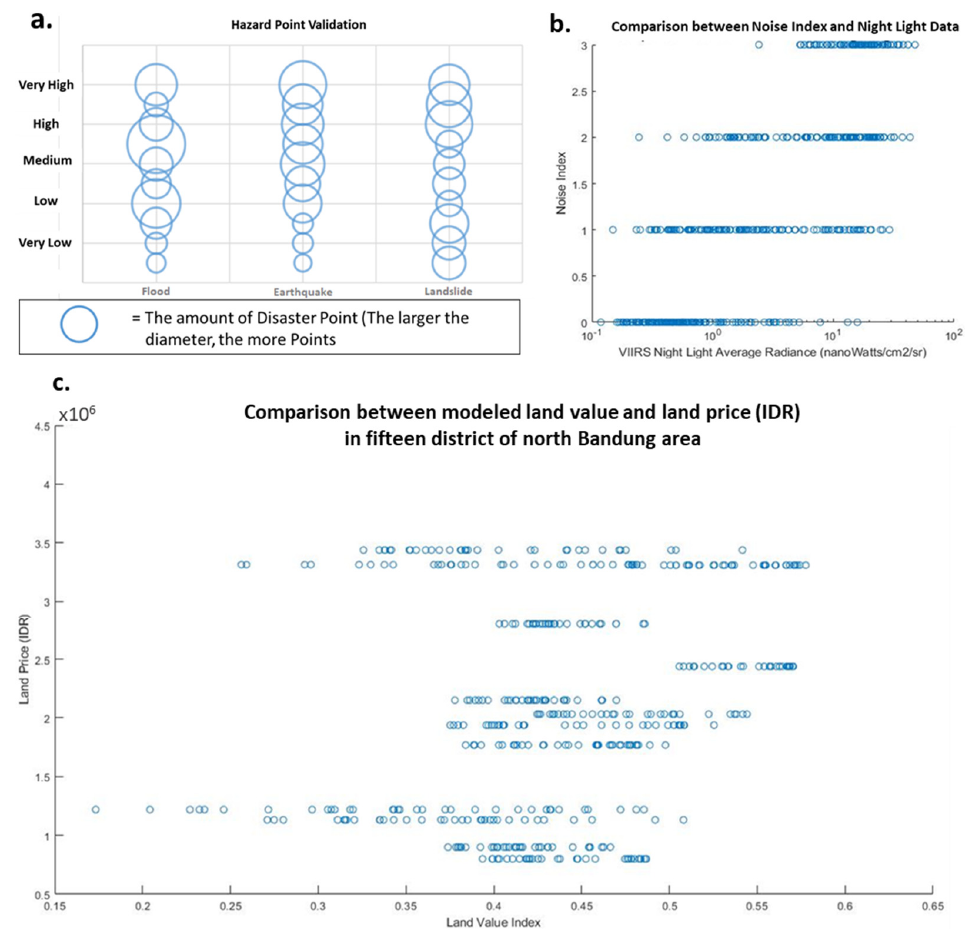
Figure 12. Image comparison of mapped results for the ( a ) validation of disaster points ( b ). Comparison between the noise index and night light data ( c ). Comparison of land value model in this study with the estimated land price in fifteen district North Bandung City area estimated by Somantri [62].